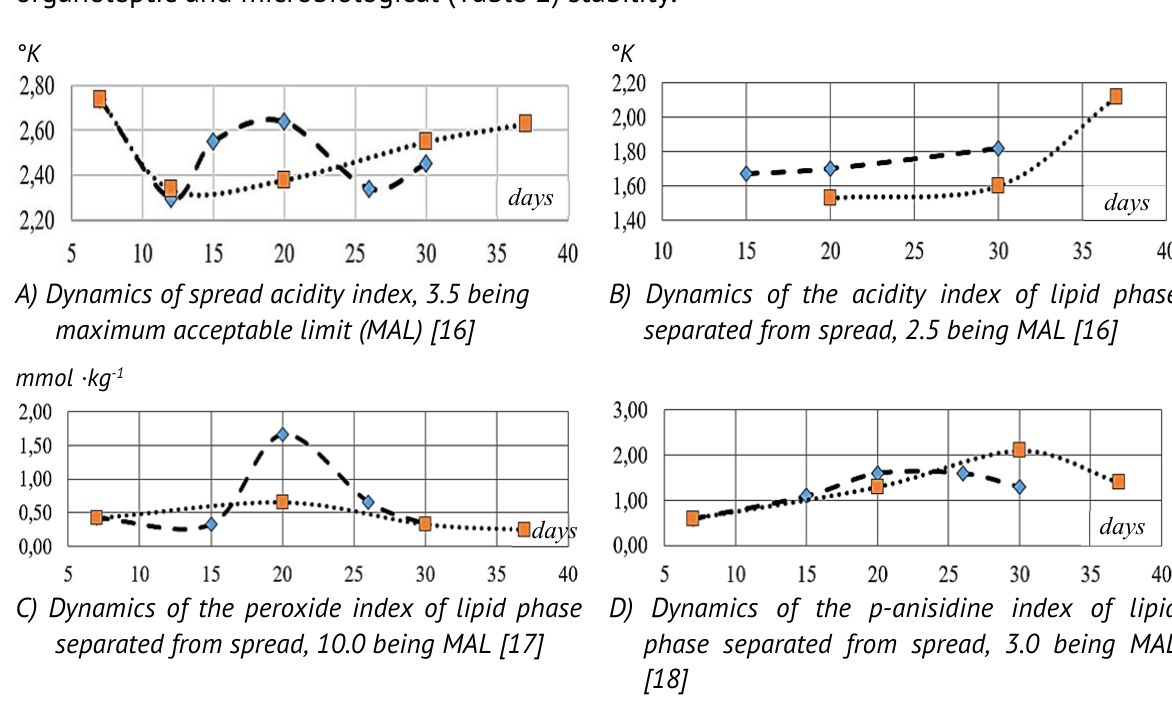
Figure 1. The evaluation of spread stability against oxidative degradation during